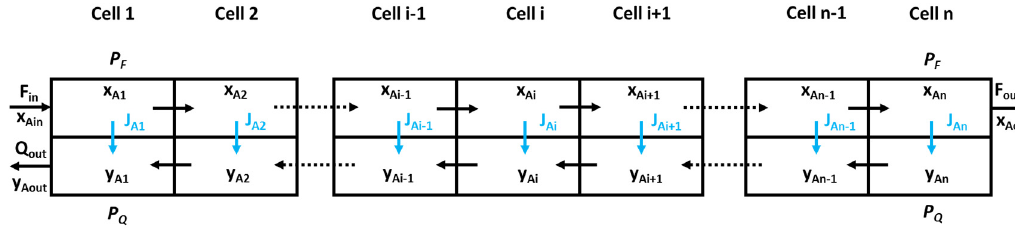
Figure 1. Scheme of the bore-side feed countercurrent flow arrangement considered in this work.